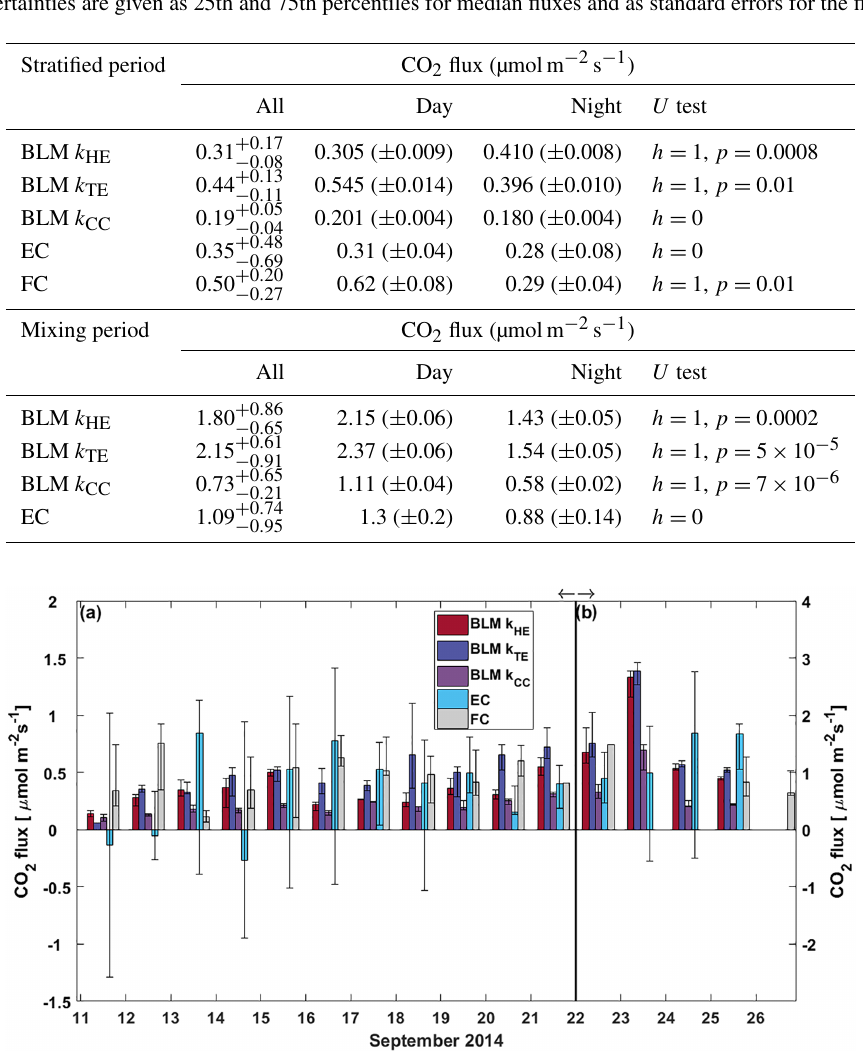
Table 3. Median of all CO 2 fluxes and average daytime and night-time CO 2 fluxes during lake stratification and mixing periods using different measurement methods. Results of Mann–Whitney U test comparing differences between daytime and night-time fluxes are given in U test column. Note that FC fluxes are averaged also over different measurement spots. Mixing period did not include enough FC measurements for this analysis. Uncertainties are given as 25th and 75th percentiles for median fluxes and as standard errors for the flux averages.